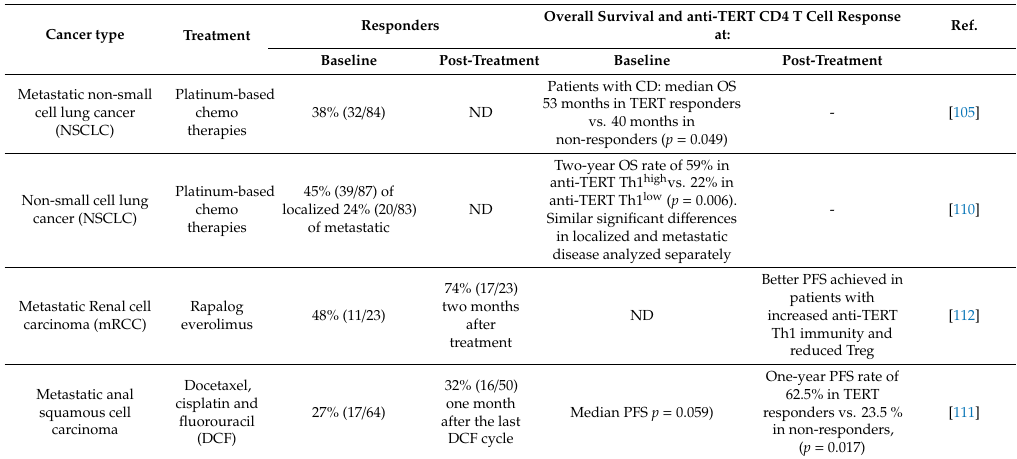
Table 2. Relationship between TERT-reactive CD4 Th1 cells and patients’